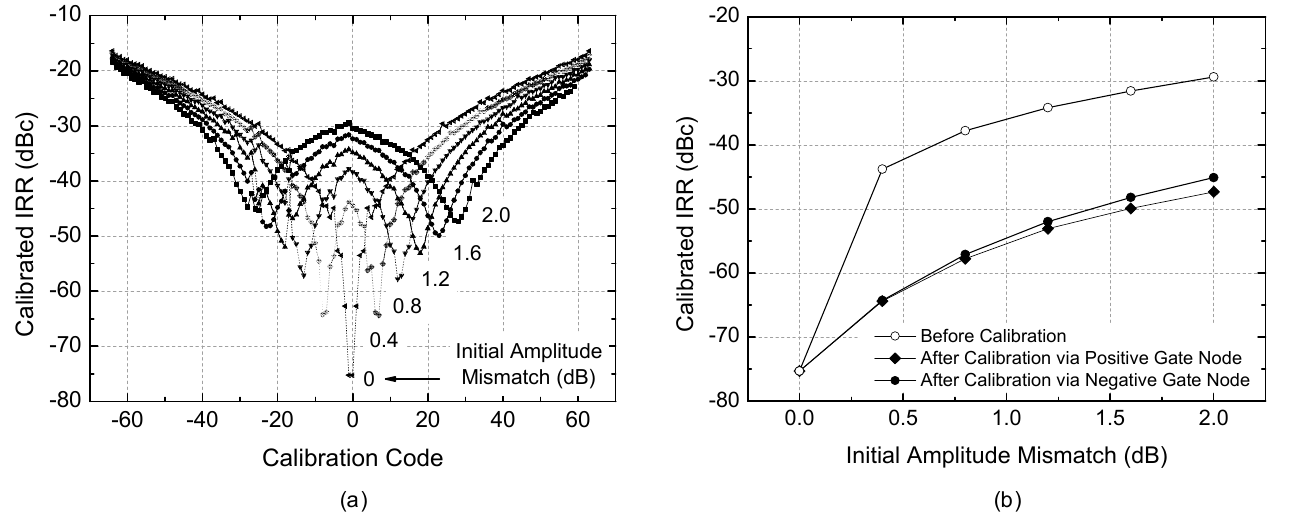
Figure 7. Simulated I/Q amplitude mismatch calibration. ( a ) IRR calibration behavior with respect to the calibration code. ( b ) Comparison of the calibrated and uncalibrated IRR with respect to the initial amplitude mismatch.